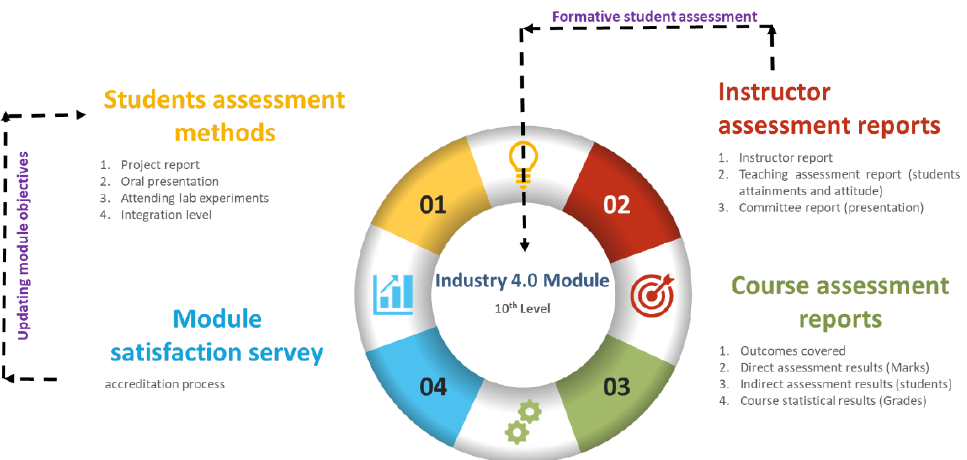
Figure 10. Curricular evaluation process designed and implemented by the University of King Saud-College of Engineering.